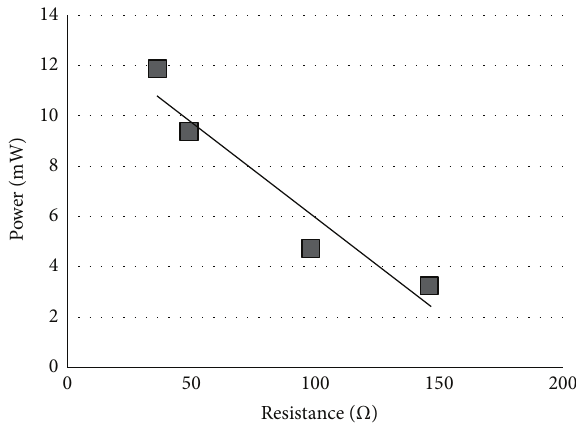
Figure 3: Power evaluation system of RFID tag chip. the evaluation board. The board has a debug functionality.